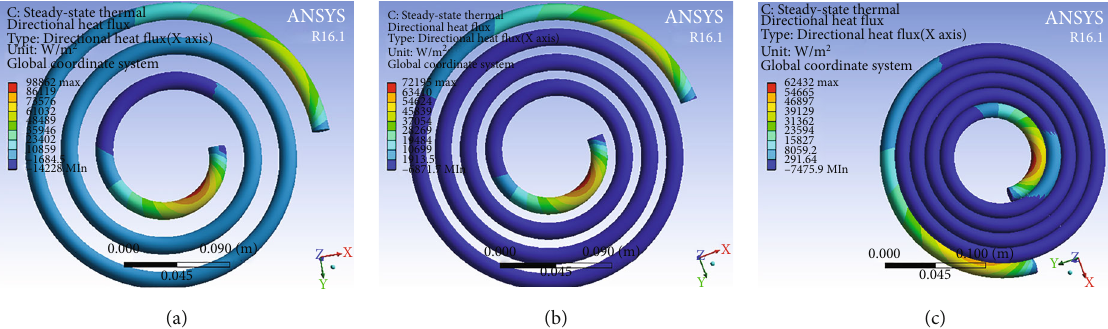
Figure 10: Directional heat fl ux distribution for (a) three convolutions, (b) four convolutions, and (c) fi ve convolutions of coil.